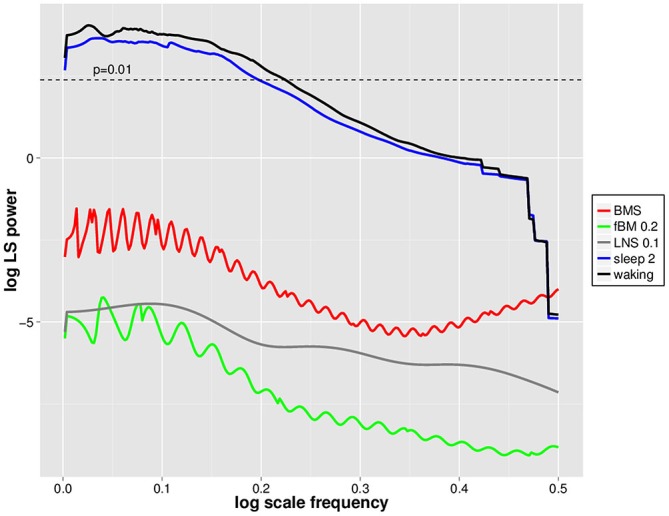
Natural log scale normalized Lomb-Scargle periodgrams for waking, sleep stage 2, log normal sigma 0.1 (LNS 0.1), binomial multifractal series (BMS; a = 0.6), and fractional Brownian Motion (fBM 0.2) avalanches. Data represent mean natural log of normalized Lomb-Scargle periodogram plots of 2.5 SD positive LVDs across 14 subjects for 8 min EEG from waking (black) and sleep stage 2 (blue), along with the same measures for a single LNS 0.1 multifractal series (gray), BMS (red), and fBM 0.2 (green). Horizontal dashed line indicates the threshold for statistical significance of normalized Lomb-Scargle periodogram peaks (p = 0.01) based upon the number of possible frequencies in the PDF estimation, as defined in Press et al. (2007).